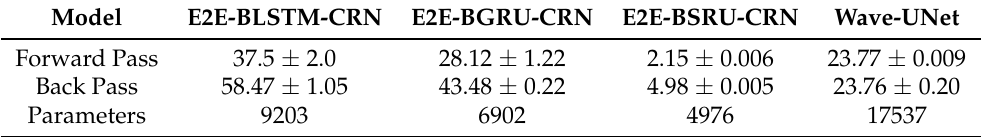
Table 8. Model Depth and computational cost.